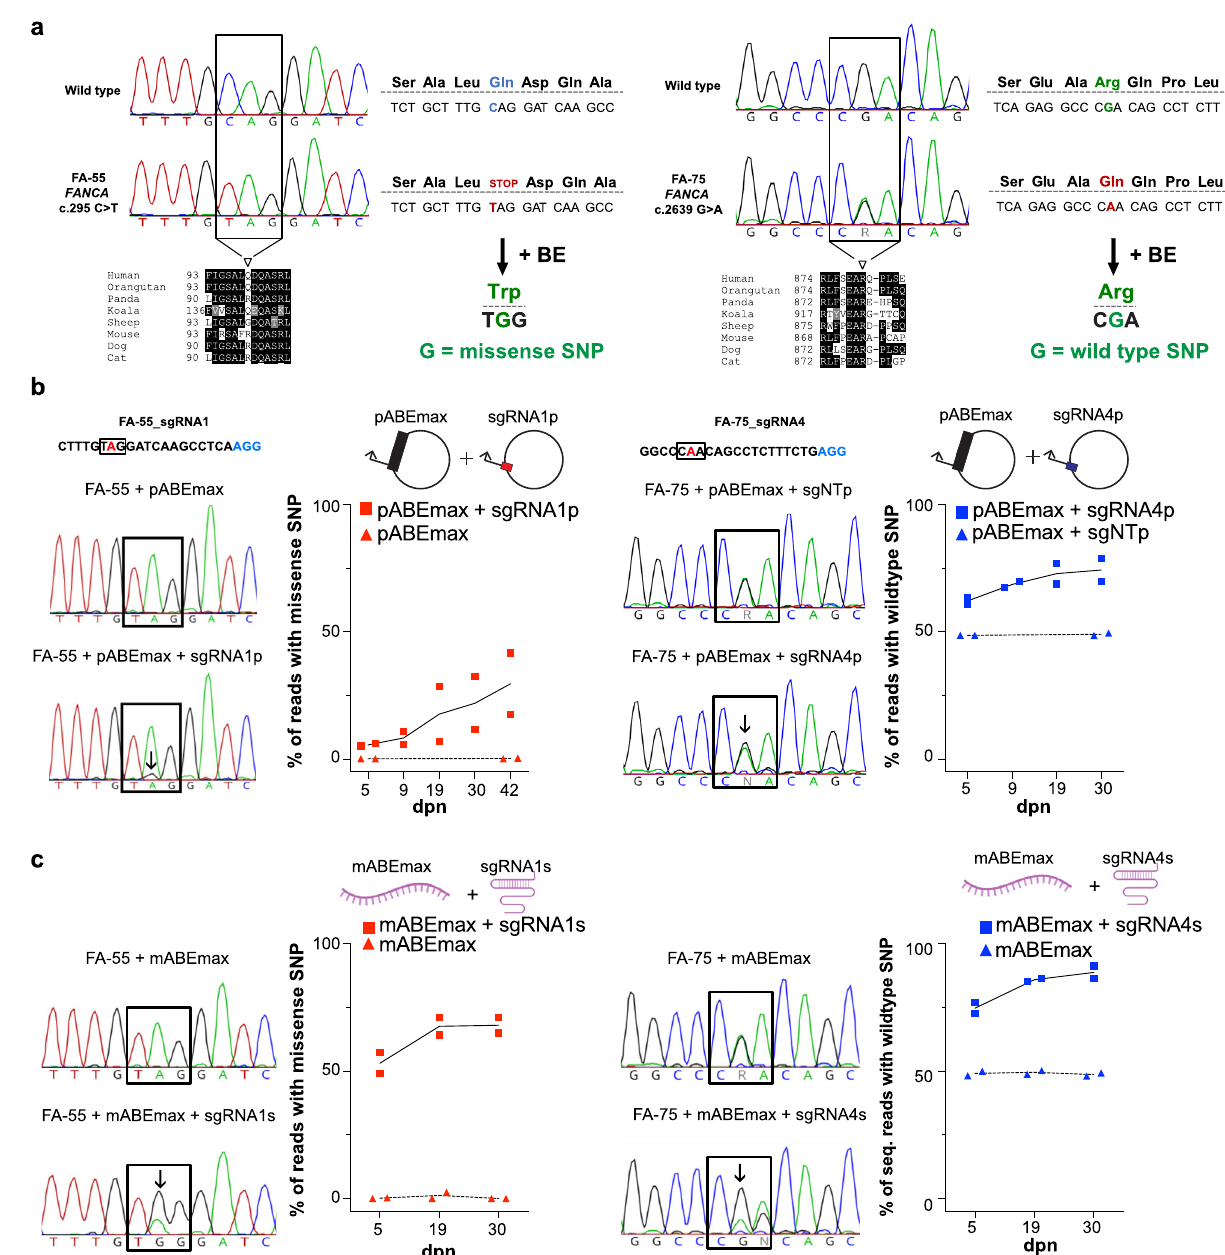
Fig. 1 | Base editing is an ef fi cient approach to modify Fanconi Anemia muta- tions. a Details of FA-55 and FA-75 mutations. Sanger traces from wild type and mutant LCLs showed the indicated c.295C>T and c.2639G>A mutations. Next to Sanger traces, translation of codons is illustrated for each mutation. FA-55 c.295 C>T mutation leads to a stop codon, terminating translation of FANCA prema- turely.AdeninebaseeditingisdesignedtointroduceamissenseSNPthatencodesa tryptophan instead of a glutamine. FA-75 c.2639G>A leads to arginine to gluta- mine mutation. Adenine base editing reverts the missense SNP to wild type sequence. FA-75 is compound heterozygous and the wild type SNP is already pre- sent in unedited cells. Below Sanger traces, protein sequence alignments from multiplespeciesareshown.Aminoacidswithdarkbackgroundorgreybackground indicate identity or similarity among different species, respectively. b Base editing inFA-55andFA-75LCLsbydeliveringABEmaxandsgRNAinplasmidformat.Onthe left top side, the FA-55sgRNA1target site isshown.PAM sequenceand editedbase arehighlightedbyblueandredfonts,respectively.TheFA-75sgRNA4siteisshown. RepresentativeSangertracesshowinitialediting5daysafterelectroporationofFA-